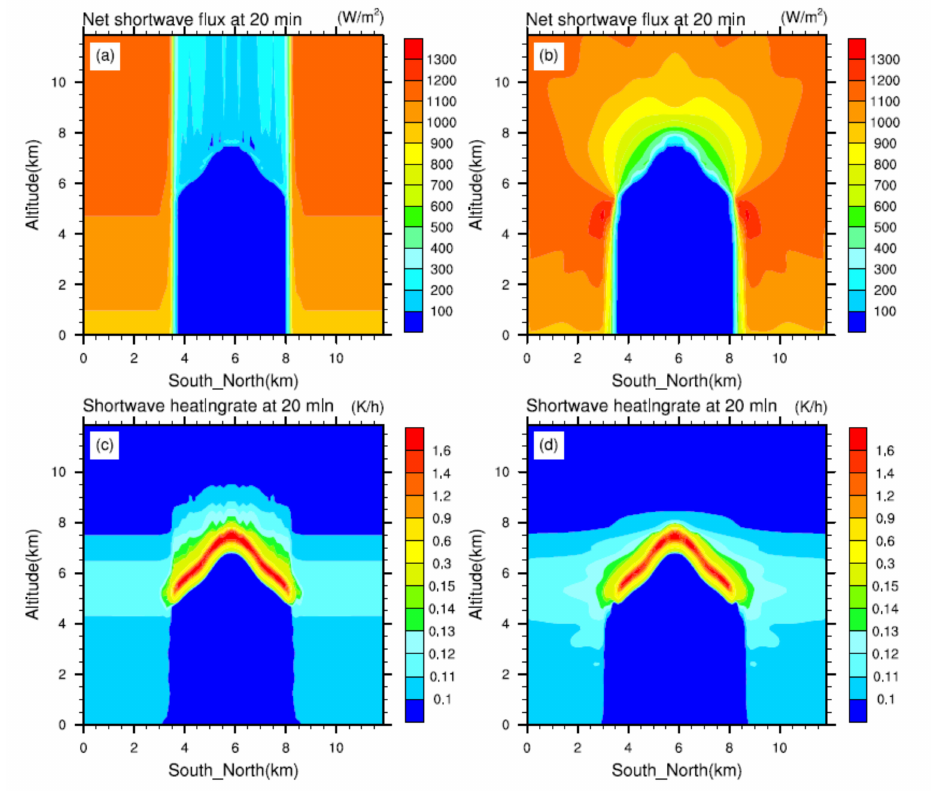
Figure 4. Net shortwave radiation flux and Shortwave heating rate in the 1D radiation case ( a , c ) and the 3D radiation case ( b , d